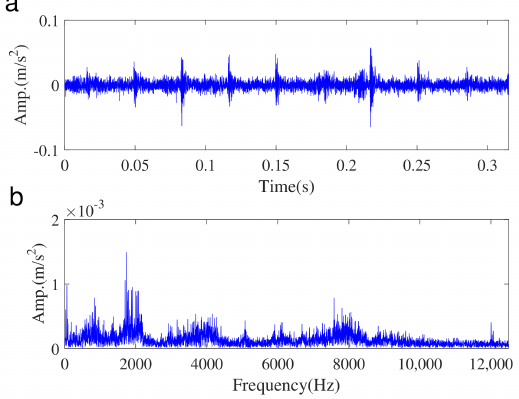
Figure 19. The original signal of tooth surface abrasion ( a ) temporal waveform ( b ) its spectrum.